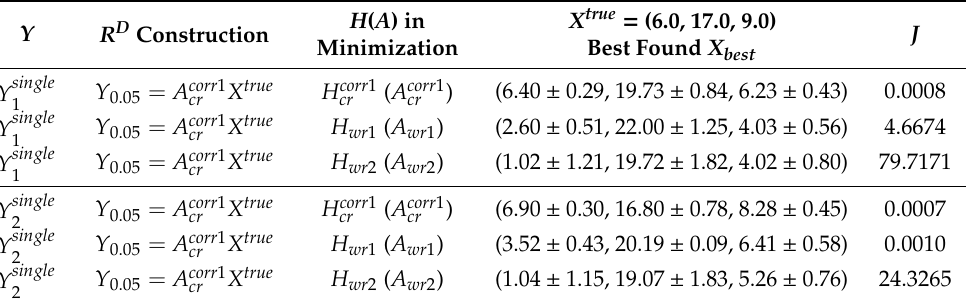
(or Y single ) denotes data from single measured radiance, 2 1